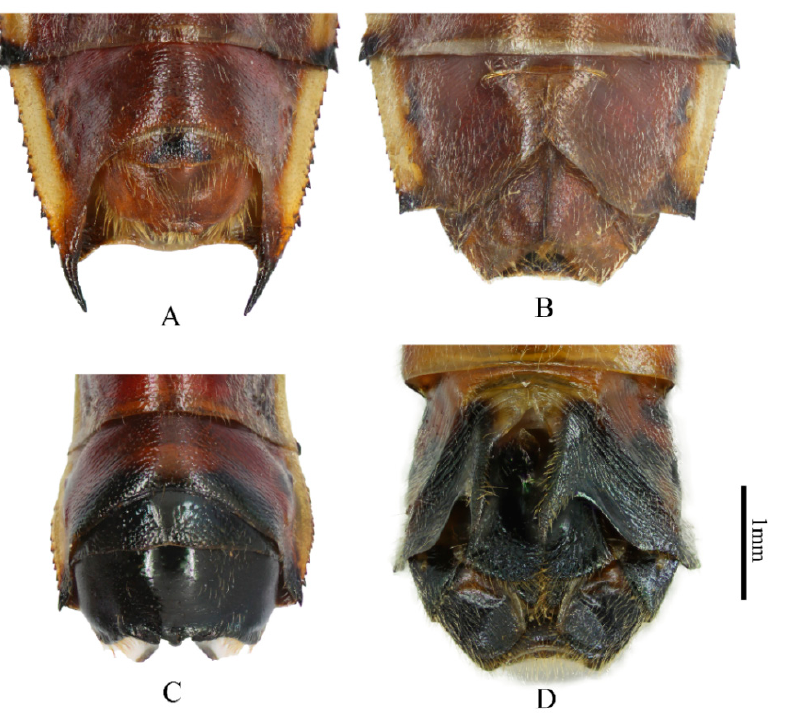
Figure 1. Ventral view of pygophore. ( A ) male of N. bispina sp. nov. , ( B ) female of N. bispina sp. nov. , ( C ) male of N. elegans , and ( D ) female of N. elegans.